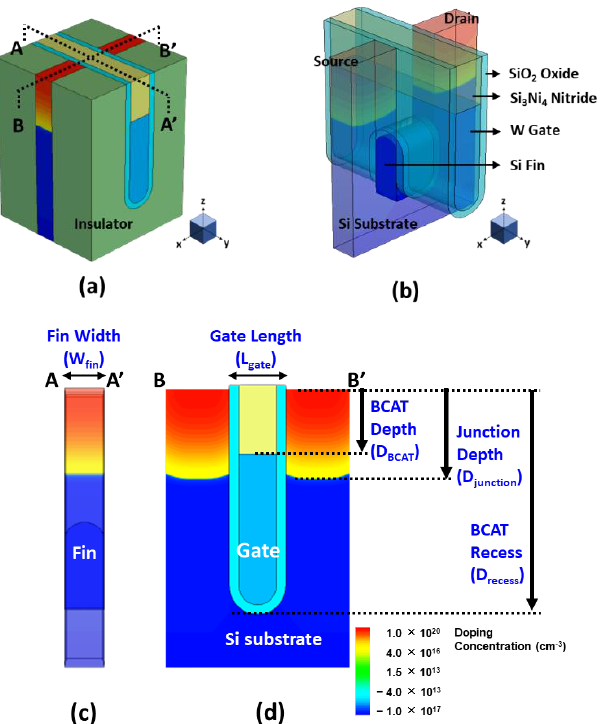
Figure 1. ( a ) A 3D bird’s eye view of the buried-channel-array transistor (BCAT), ( b ) its saddle-fin- shaped silicon channel, and its cross-sectional view ( c ) across the channel (A–A’) and ( d ) along the channel (B–B’). Note that the substrate/body region was doped with 10 17 cm − 3 boron, while the source and drain regions were counter-doped with 10 20 cm − 3